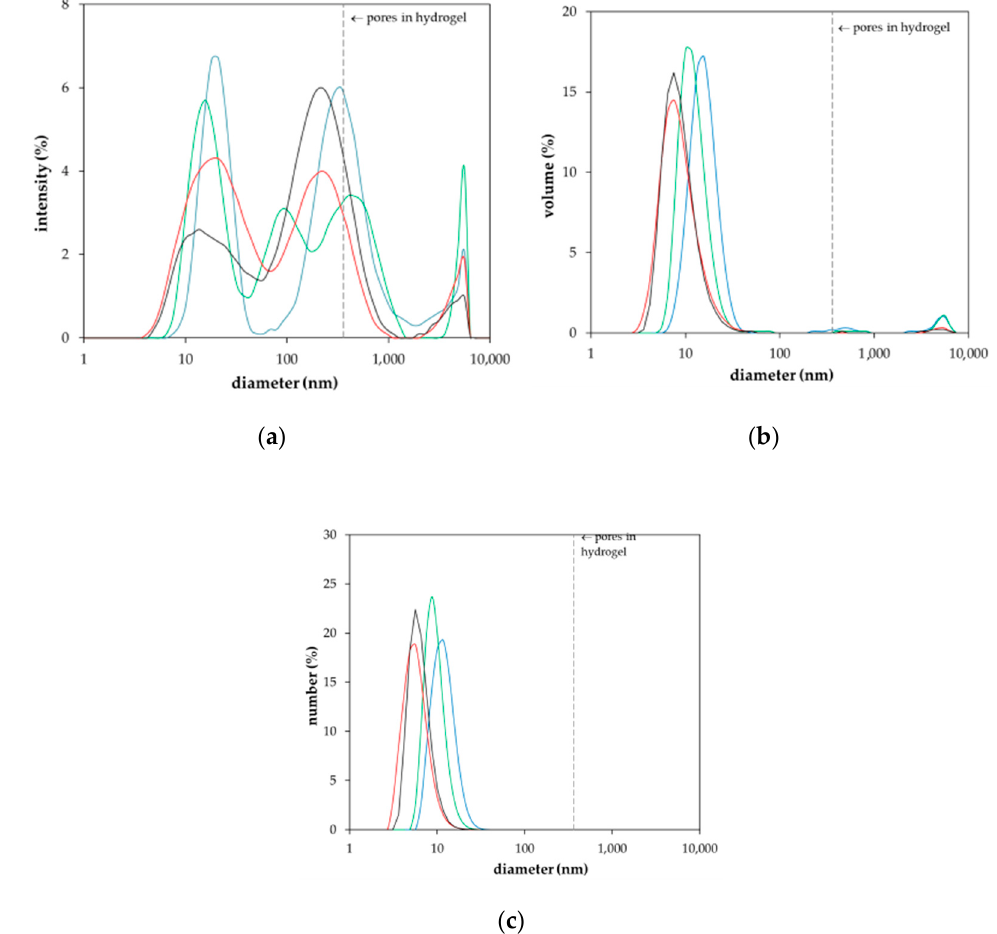
Figure 5. Intensity ( a ), volume ( b ) and number ( c ) particle size distributions of lignohumate with concentration 0.001% wt. (blue), 0.01% wt. (green), 0.1% wt. (red) and 1% wt. (black).